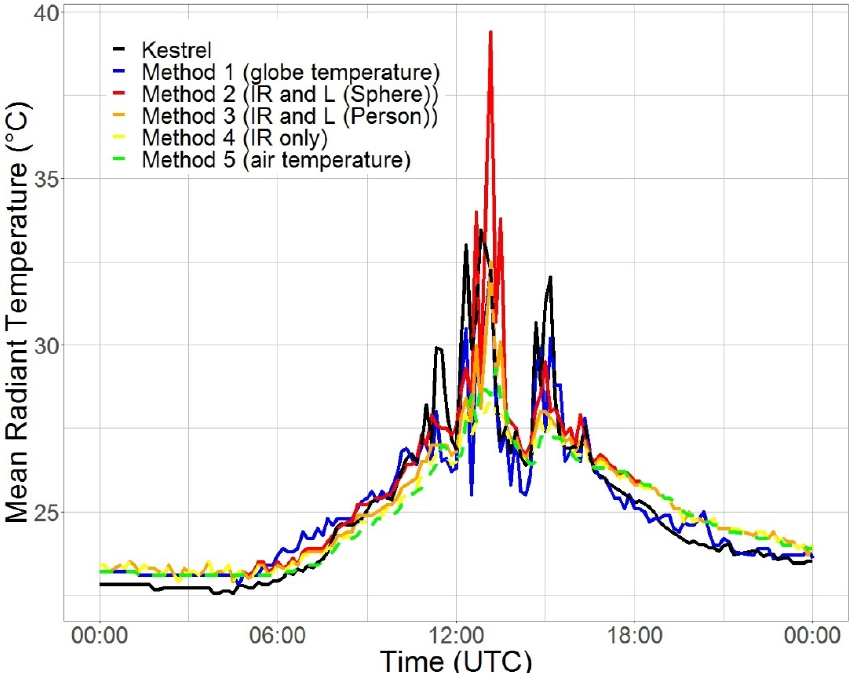
Figure 4. Mean radiant temperature (°C) in an office in Freiburg on 8 August 2021, calculated by a Kestrel 5400 Heat Stress Tracker and the five different calculations methods (Table 2) using data from the MoBiMet.